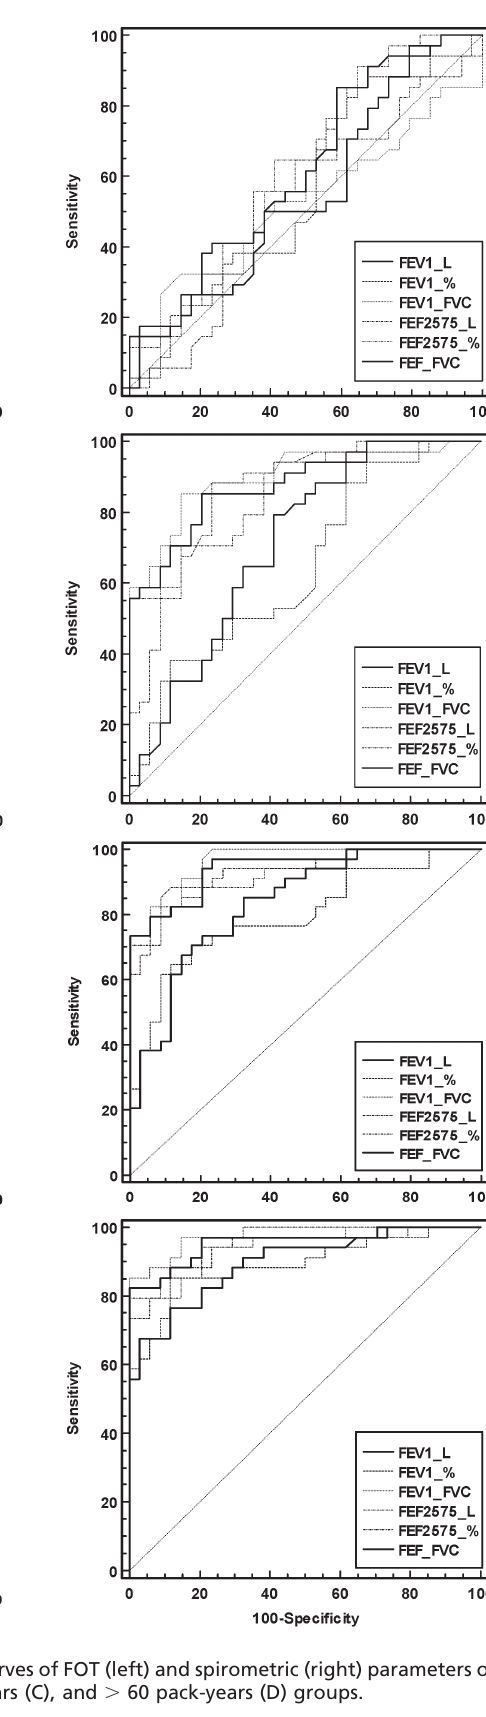
Tobacco consumption: its deleterious effects and diagnosis Faria ACD et